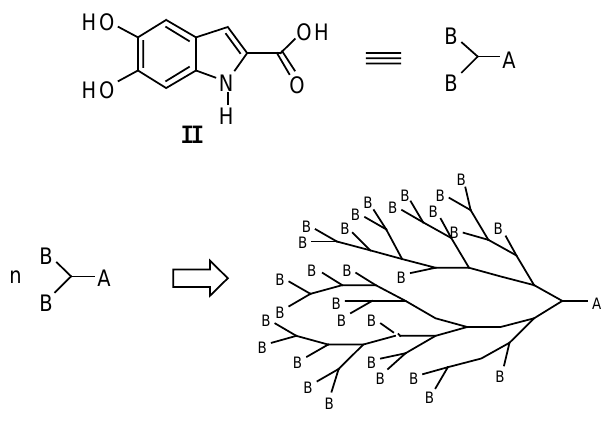
Figure 3 . Schematic architecture of the hyperbranched macromolecules originating from AB monomers. 2 HHO N